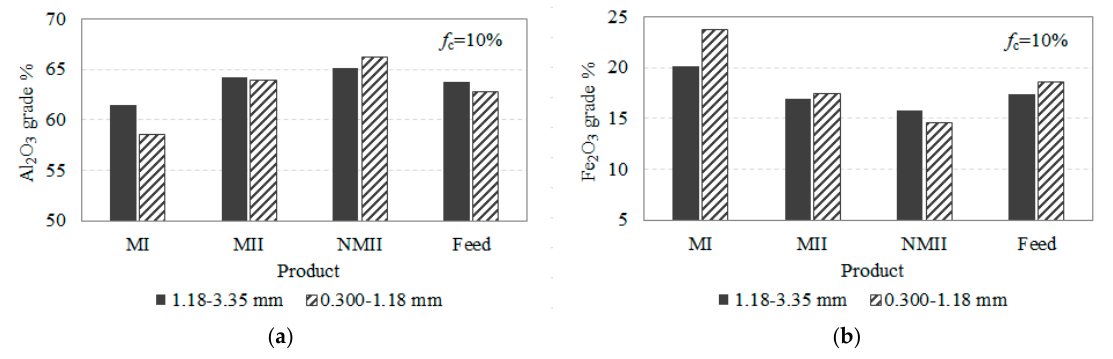
Figure 10. ( a ) Al 2 O 3 grade and ( b ) Fe 2 O 3 grade in the magnetic separation products for the 1.18 – 3.35 and 0.300 – 1.18 mm fractions, when the material filling volume f c was 10%. and 0.300–1.18 mm fractions, when the material filling volume f c was 10%.